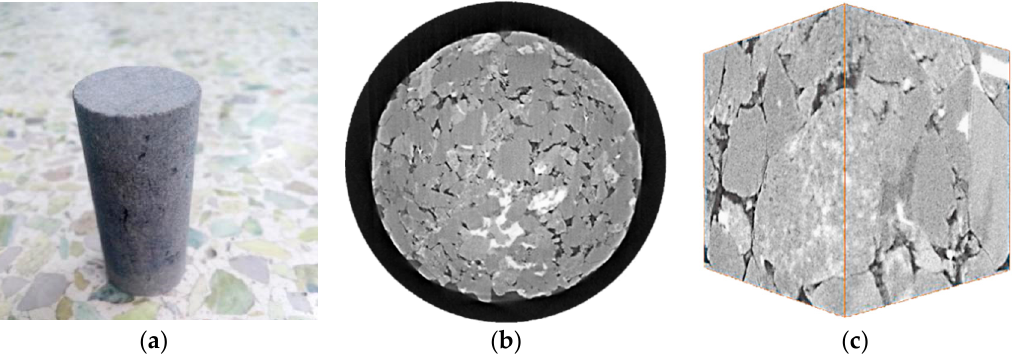
Figure 3. Digital core scanning and modeling images. ( a ) Plunger core, ( b ) cross-sectional view by CT, and ( c ) core numerical model.